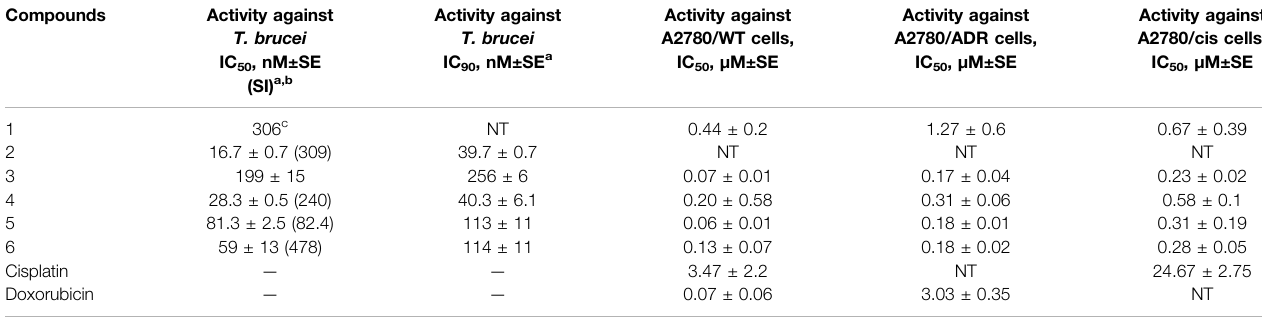
TABLE 2 | In vitro activities of 1 – 6 and positive controls against T. brucei bloodstream forms and ovarian cancer cell lines. Compounds Activity against T. brucei